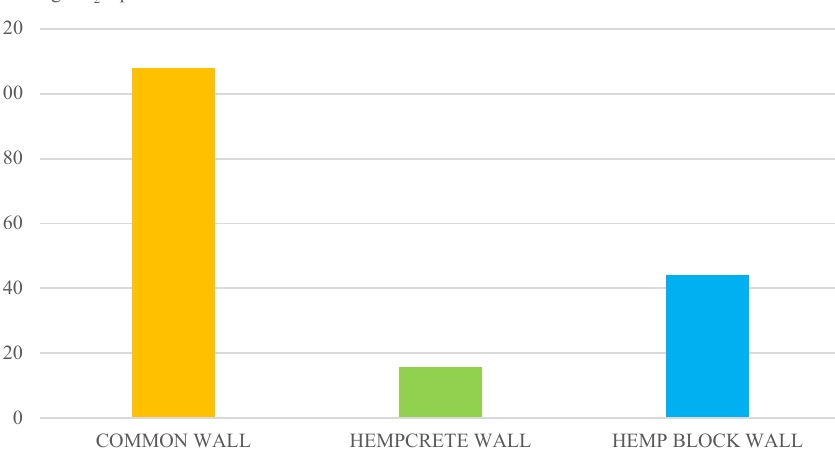
Fig. 5. Comparison among 1 m 2 of hempcrete wall, hemp blocks wall, common wall – (IPCC GWP 100a kg CO 2